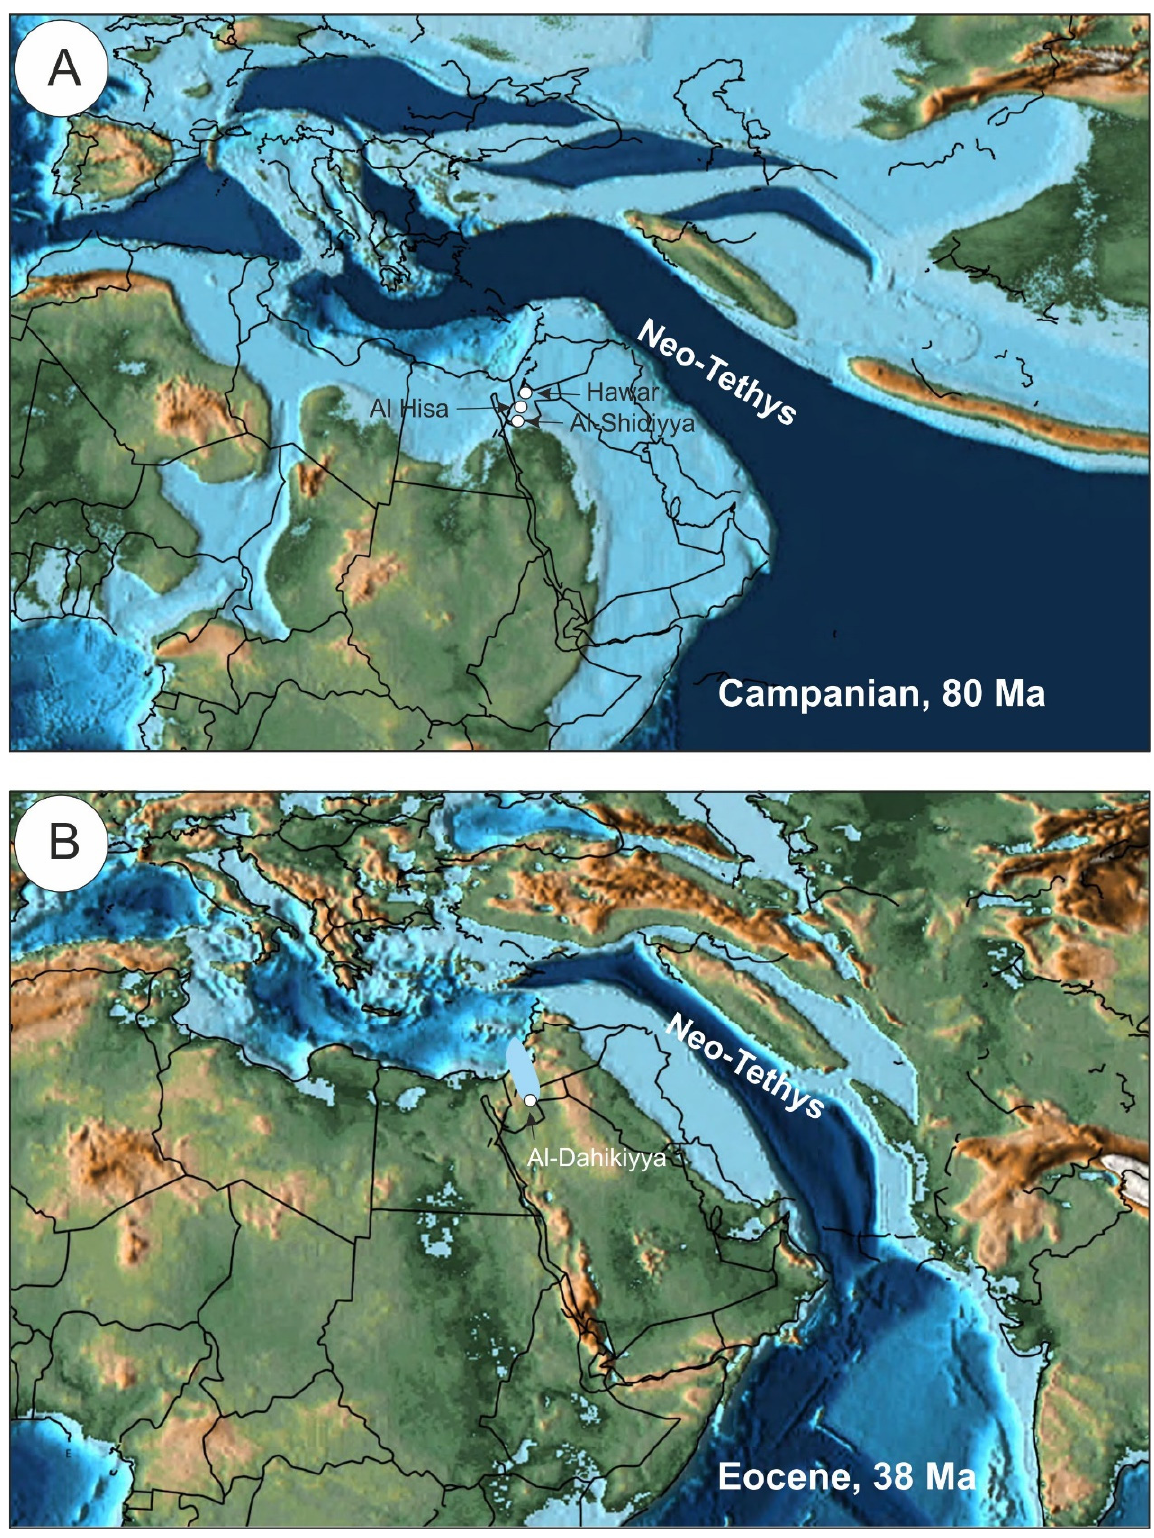
Figure 1. Paleogeographic maps of Jordan and Neo-Tethys during the Campanian and Eocene periods: ( A ) location position of HawarAl-Hisa and Al-Shidiyya sections in the southern Neo-Tethys showed that deposition of phosphate occurred in the epicontinental sea during Campanian period; and B ) location position of Al-Dhahikiyya during Eocene period represents the gateway from Al-Dhahikiyya into Neo-Tethys (modified after Ref. [33] and [34 ]).